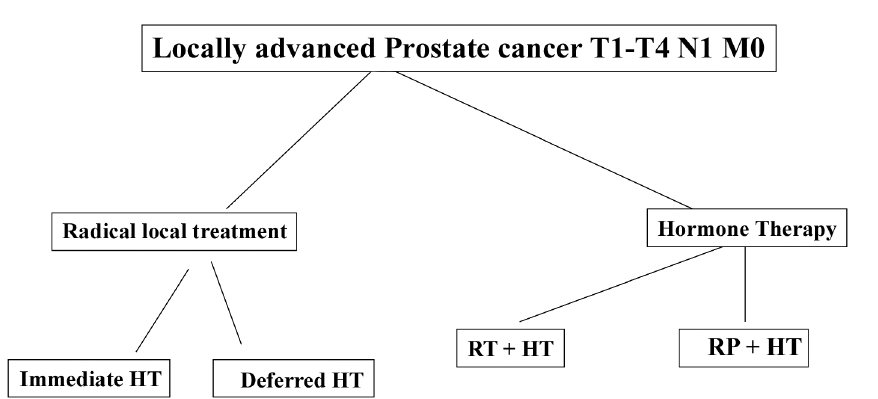
Figure 3 – Treatment options for T1-T4 N+ M0 prostate cancer candidates. Recommendation of the International Consultation on Prostate Cancer (ref. 7). HT = hormone therapy; RT =